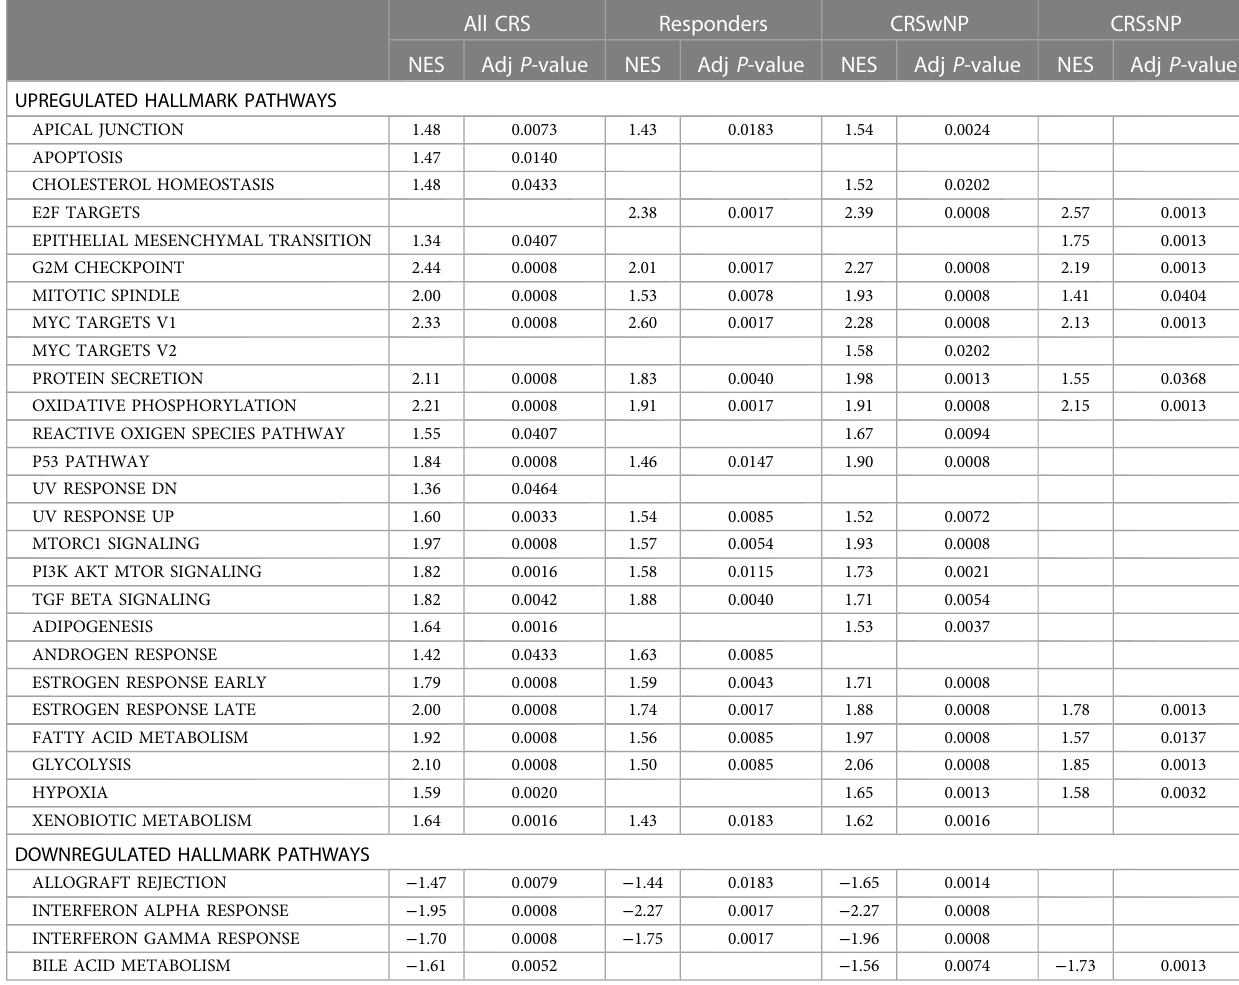
TABLE 2 Signi fi cant GSEA pathways in subgroups: (i) All CRS patients, (ii) Chronic sinusitis with nasal polyps (CRSwNP), (iii) Chronic sinusitis without nasal polyps (CRSsNP), (iv)